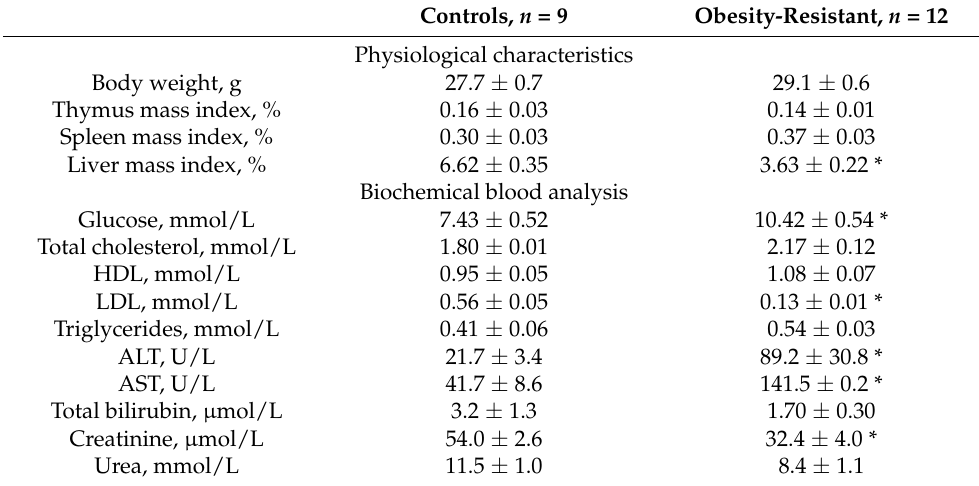
Table 1. Baseline characteristics of mice in the control and obesity-resistant